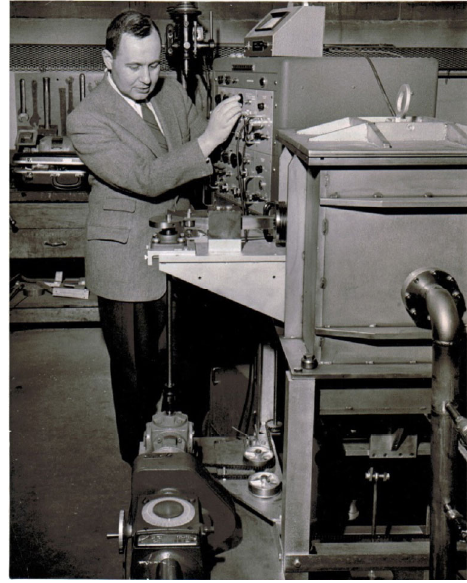
Fig. 1 Ernest Rabinowicz “hard at work”. On this photo taken in the late 1950s or early 1960s he is absorbed in work with a cylinder on cylinder rolling tester [10].